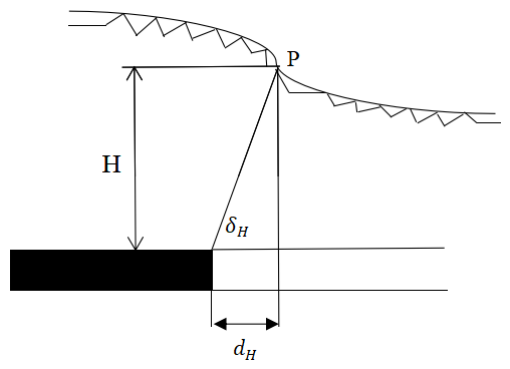
Figure 16. Schematic diagram of the sliding ground